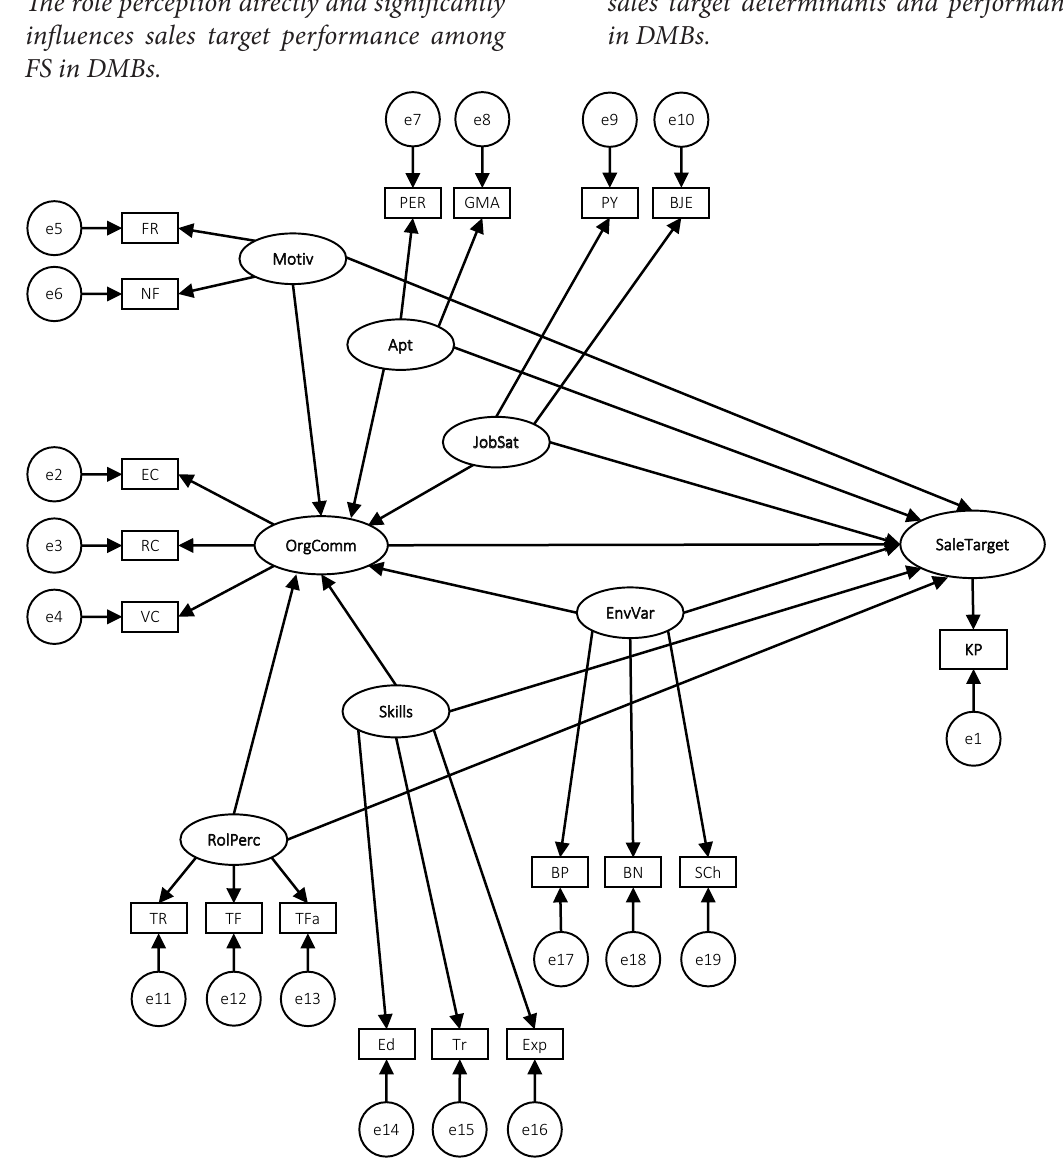
Figure 1. Preliminary conceptual